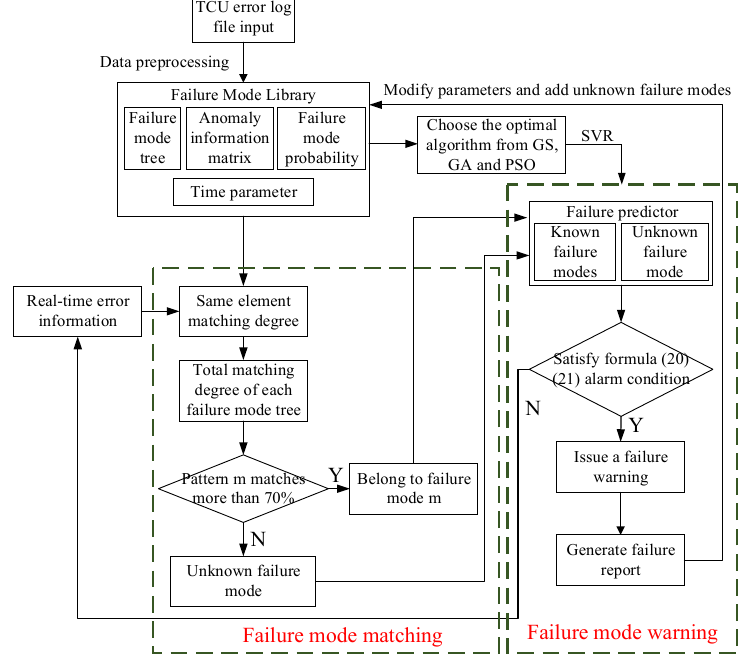
Figure 10. Flow chart of TCU failure prediction in an electromagnetic environment based on pattern matching and SVR. TCU, thyristor control unit; SVR, support vector regression.